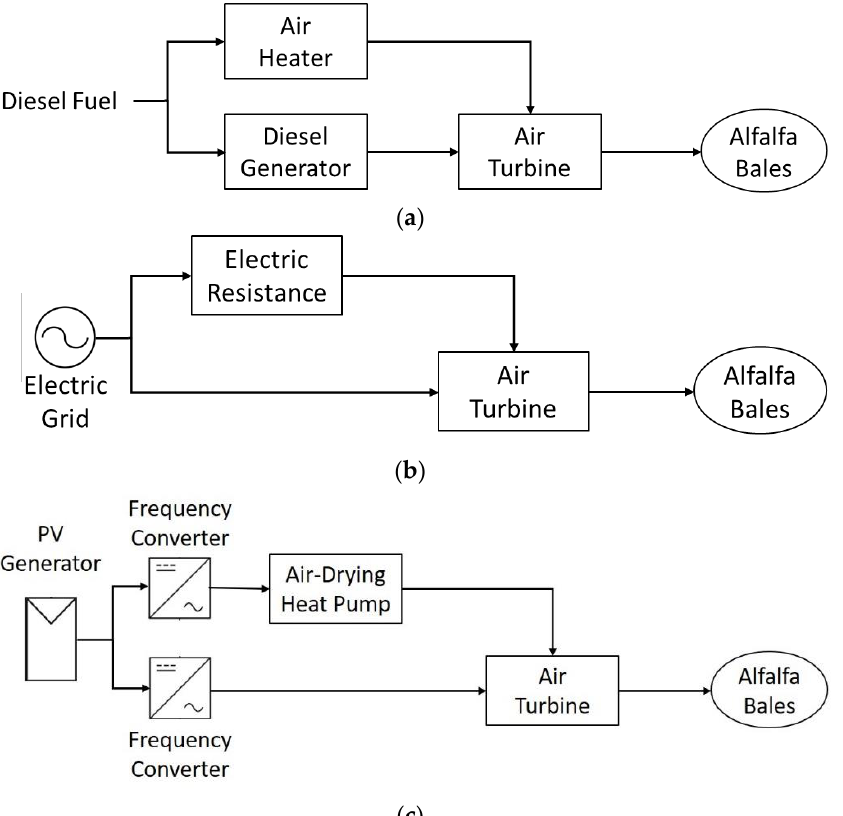
Figure 1. Schematic of the diesel-powered drying system ( a ), grid-powered drying system ( b ), and PV-powered drying system ( c ).